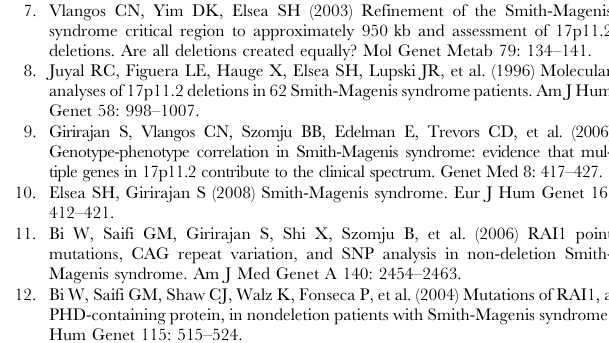
Figure S1 RAI1 mRNA expression in lymphoblastoid cells with different control assays. Figure S2 Results of MLPA copy number analysis on genomic DNA from all lymphoblastoid cell lines used for RAI1 expression analysis. Table S1 (A) RAI1 haplotype assignments to our non analysis of alleles in